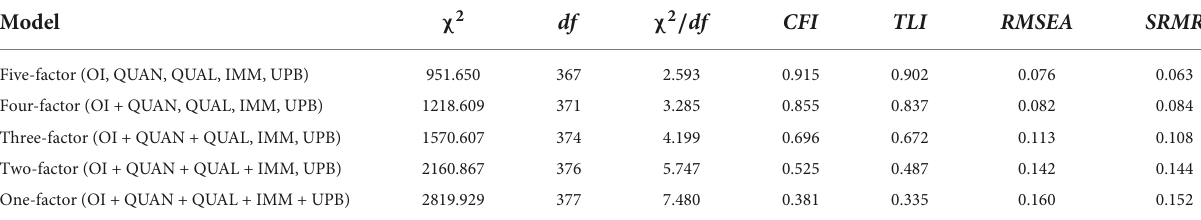
TABLE 2 Results of confirmatory factor analysis (CFA) ( N = 254).